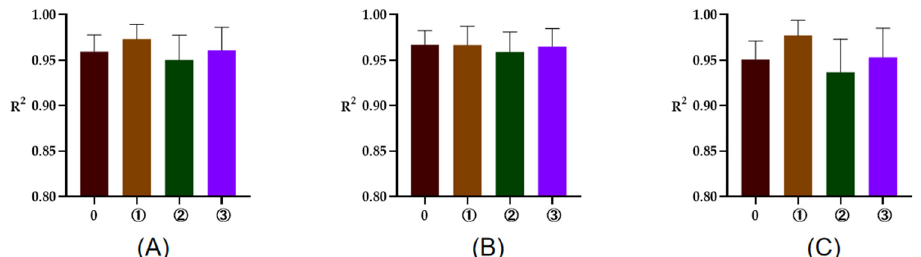
Figure 2. The R 2 of fitted curve of DM, CP, and OM of energy feeds of 5 or 7 time points. ( A – C ), respectively, represent the R 2 of fitted curve of DM, CP, and OM in the rumen of energy feeds. The number 0 = 7 incubation time points, ① , respectively, the R 2 of fitted curve of 2, 16, 24, 36, 48 h; ② , respectively, the R 2 of fitted curve of 2, 8, 16, 24, 48 h; ③ , respectively, the R 2 of fitted curve of 2, 8, 16, 36, 48 h.